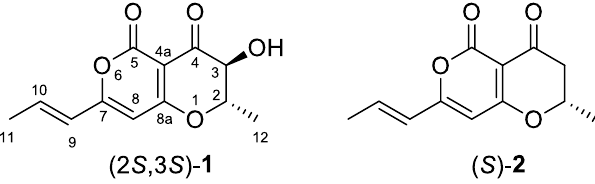
Figure 1. Structure of radicinin ( 1 ) and 3-deoxyradicinin ( 2 ).